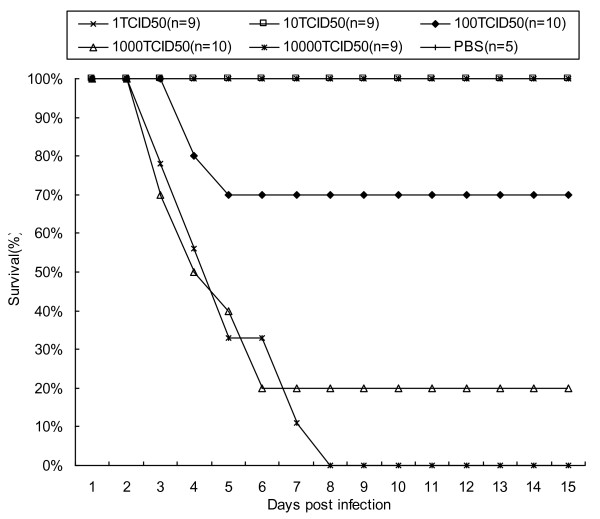
50% lethal dose (LD50) assay. Two-day-old BALB/c mice were infected intraperitoneally with 100 μl of purified Hn2 virus in dilutions, ranging from 1TCID50 to 10000TCID50. The survival rates were observed for 21 days.